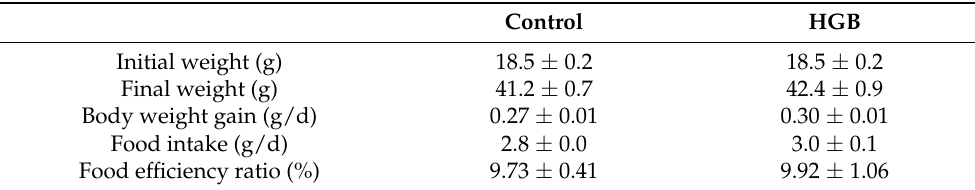
Table 3. Weight gain, food intake, and food efficiency ratio.